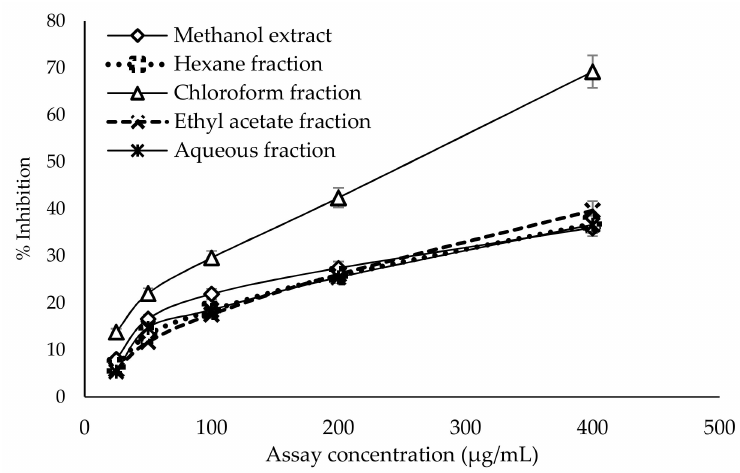
Figure 2. Dose–response relationship of methanol extract and its fractions of G. edulis for antiglycation activity determined by glucose-induced protein glycation and formation of protein-bound fluorescent advanced glycation end products. Data presented as mean ± standard deviation ( n = 4).